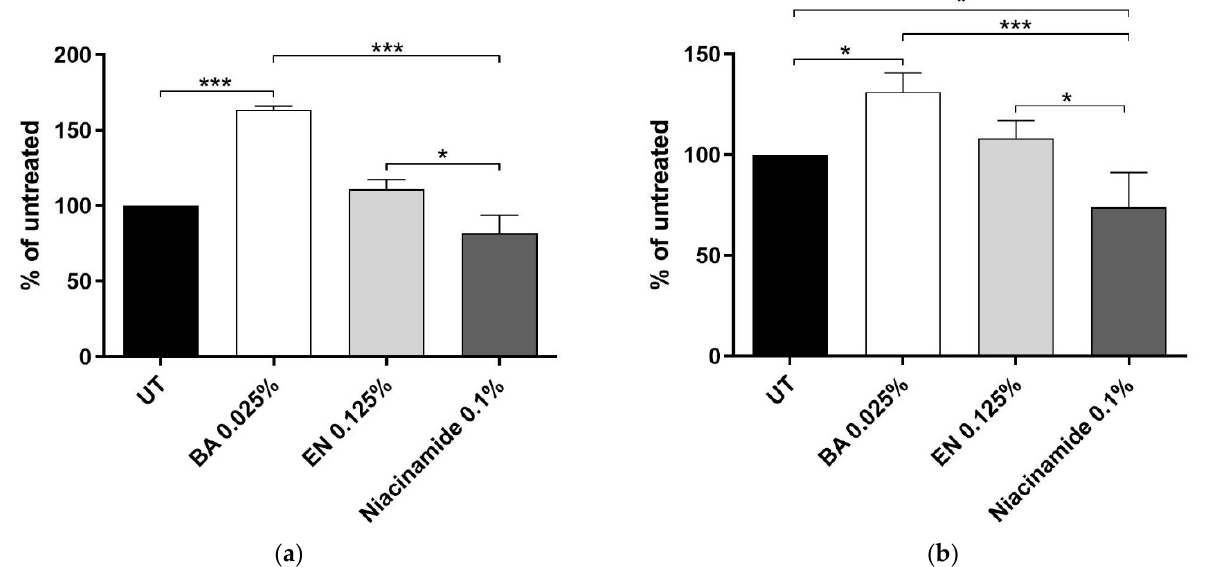
Figure 2. Gene expression analysis of skin barrier genes. Human primary keratinocytes were treated for 24 h with ( a ) single extracts: BA 0.1% (white) or EN 0.5% (grey) and ( b ) combination of extracts: BA 0.05% + EN 0.25% (striped). Relative gene expression was determined using the 2 - ΔΔ Ct method. Results are presented as fold change compared to untreated where ( a ) n = 5 and ( b ) n = 3 number of donors. Statistics was calculated on Δ Ct values with ( a ) repeated measures ANOVA and post-test Tukey or ( b ) paired Student’s t-test where p * ≤ 0.05, p ** ≤ 0.01 and p *** ≤ 0.001. Fold change for untreated was set to 1. Values are displayed as mean (±SD).